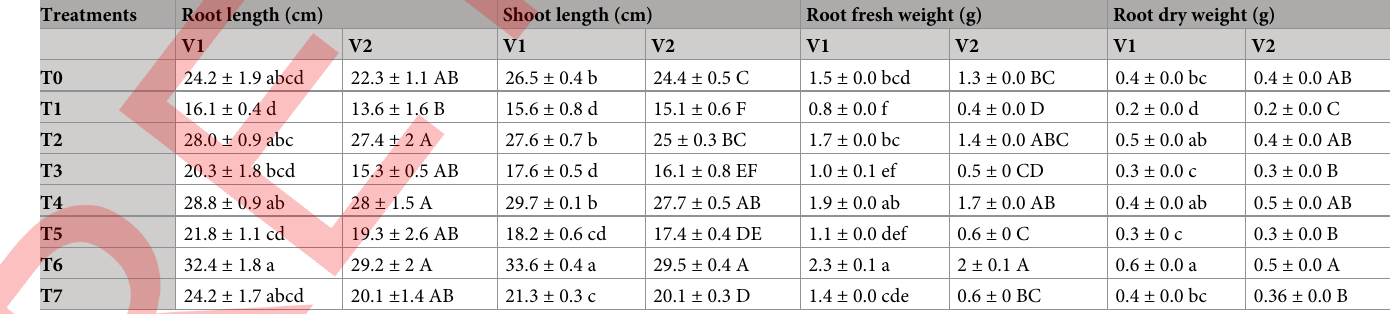
Table 1. Effect of biochar and compost on length and root biomass of Spinacia oleracea in cadmium contaminated soil. Mean of three replicates and standard devia- tion are presented. Different letters shows significant difference among treatments. Control (T0), 10 ppm CdCl 2 (T1), biochar 1% (T2), biochar 1% + 10 ppm CdCl 2